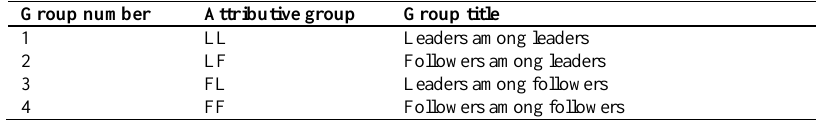
Table 1. Identification of attributive groups according to the level of sustainable development of regions